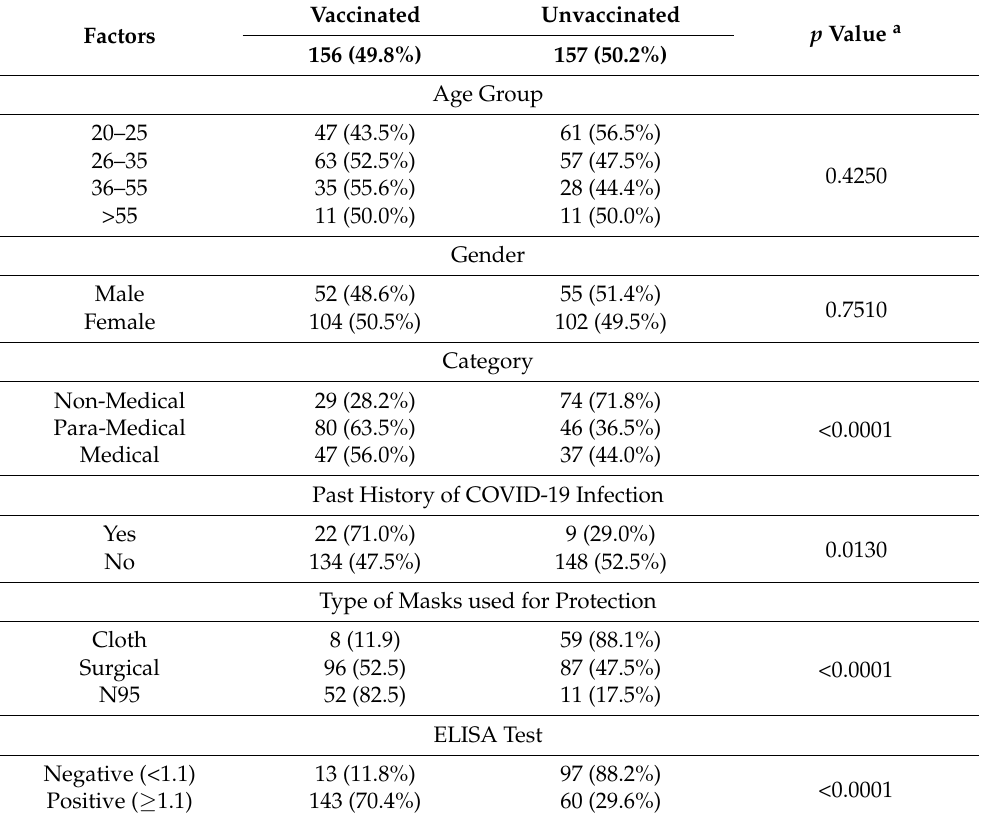
Table 1. Characteristics of study participants by their vaccination